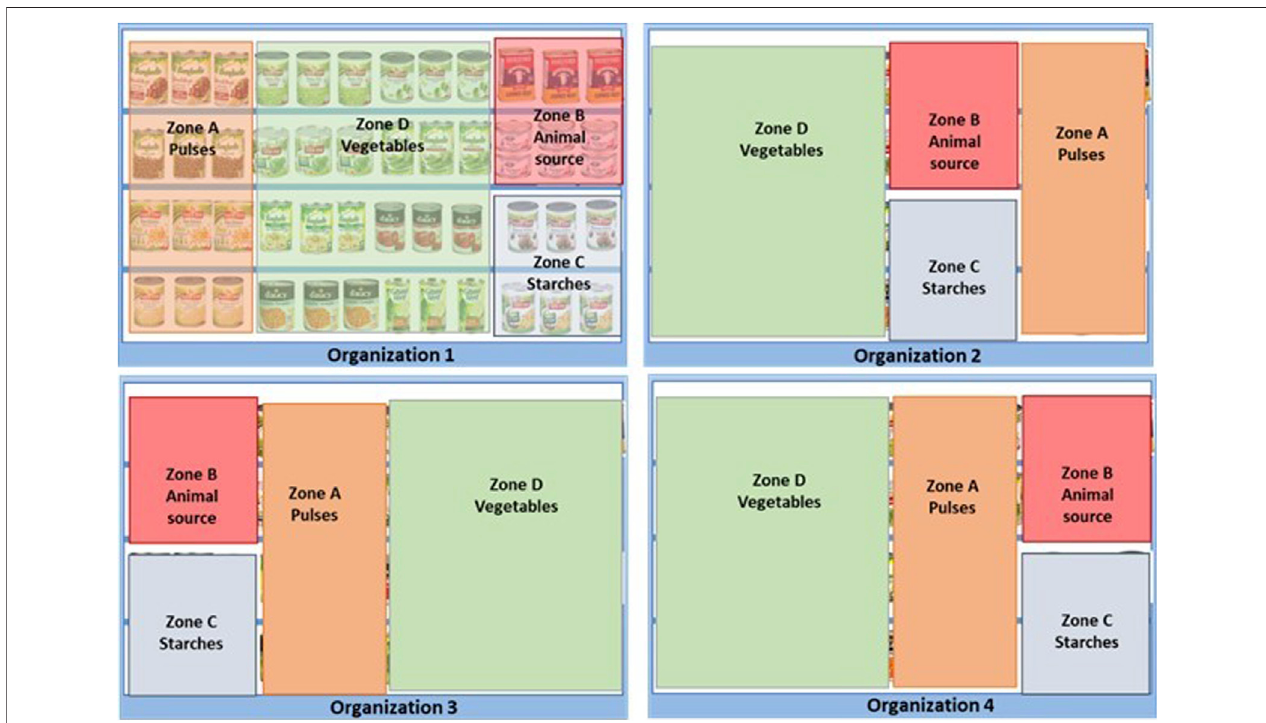
FIGURE 2 | Example of the four organizations of the canned shelf used in the test, to balance the position of food-groups across participants. Red is used for animal-based products, green for vegetables, blue for starches, and orange for pulses.